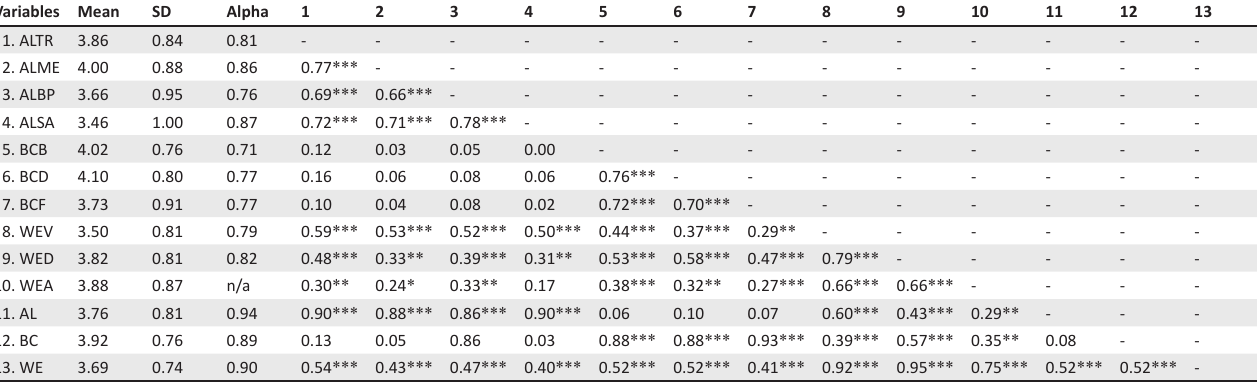
TABLE 1: Means, standard deviations, reliabilities (Cronbach’s alpha) and Pearson’s correlations for all variables. Variables Mean SD